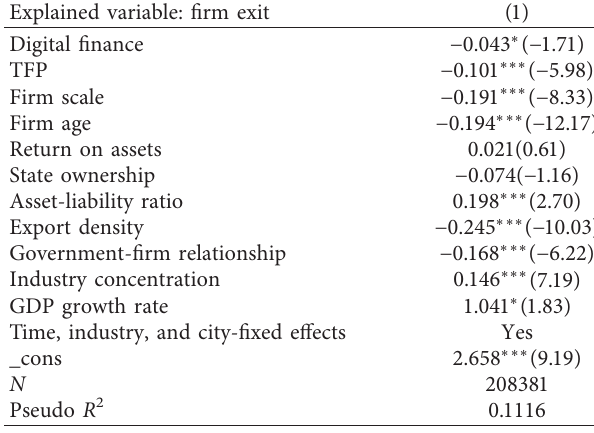
Table 3: Regression results on digital finance and firm